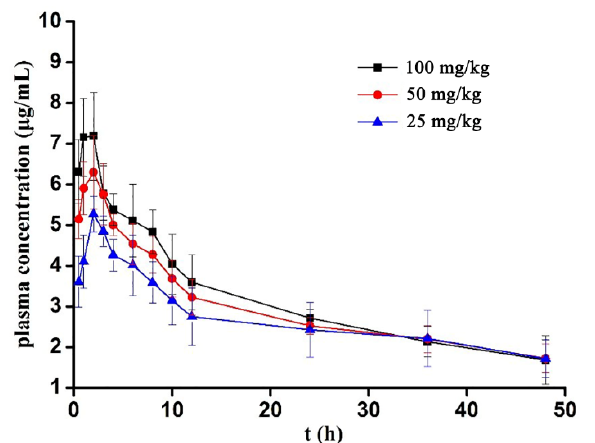
Figure 1. Mean-plasma concentration–time profile of LBP-FITC after intragastric administration of LBP-FITC to rats.